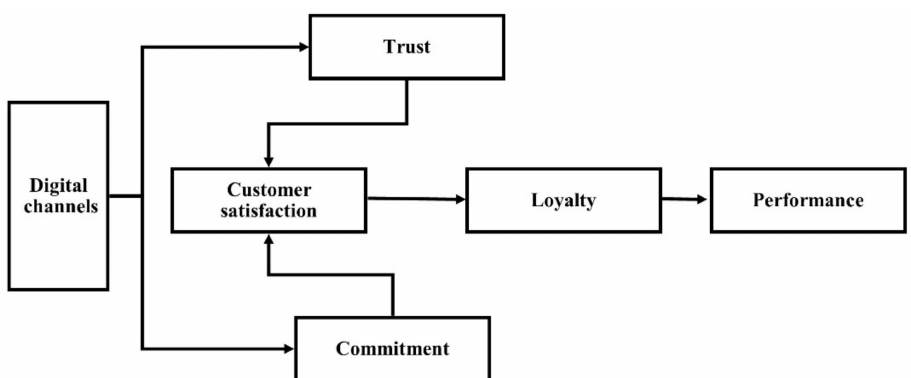
Figure 1. Relationship between digital channels and business performance. Note: loyalty build- ing based on trust and commitment in financial technologies. Source: own elaboration based on Minta